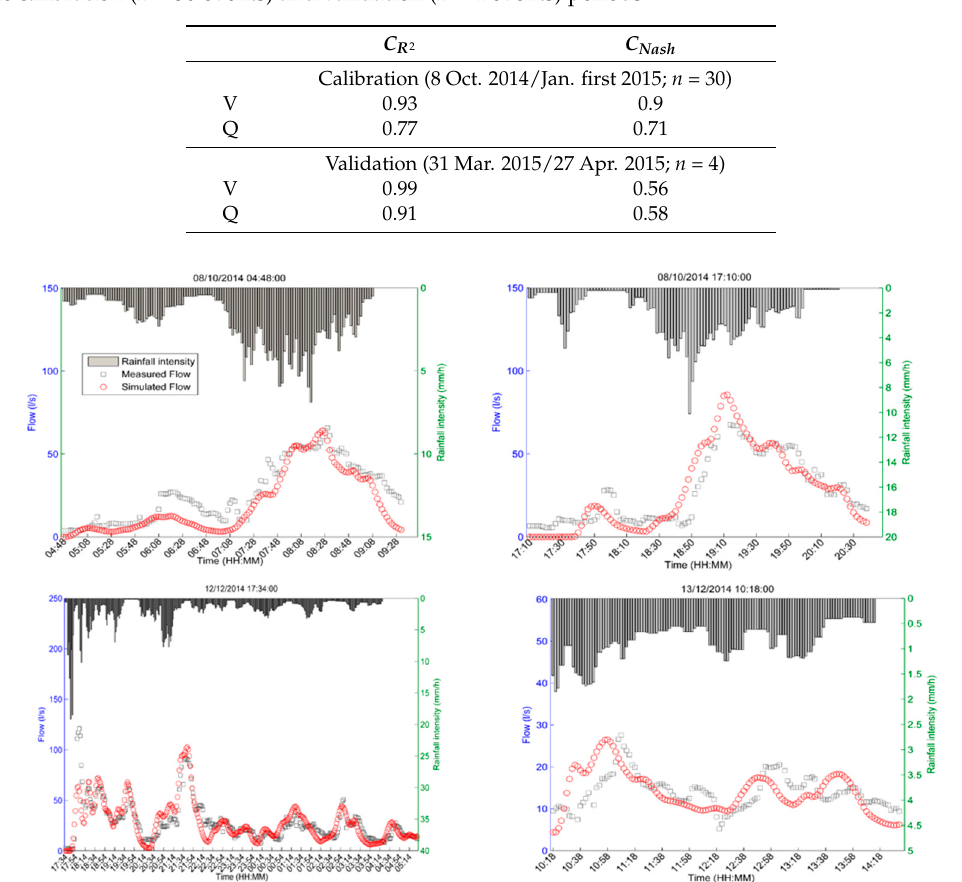
Figure 4. Water flow simulations for four events from the period from 8 October 2014 to 31 December 2014. The simulated flow at the outlet is represented by red circles. The measured flow is represented by grey squares. The rainfall intensity is plotted on the upper part of the figures.